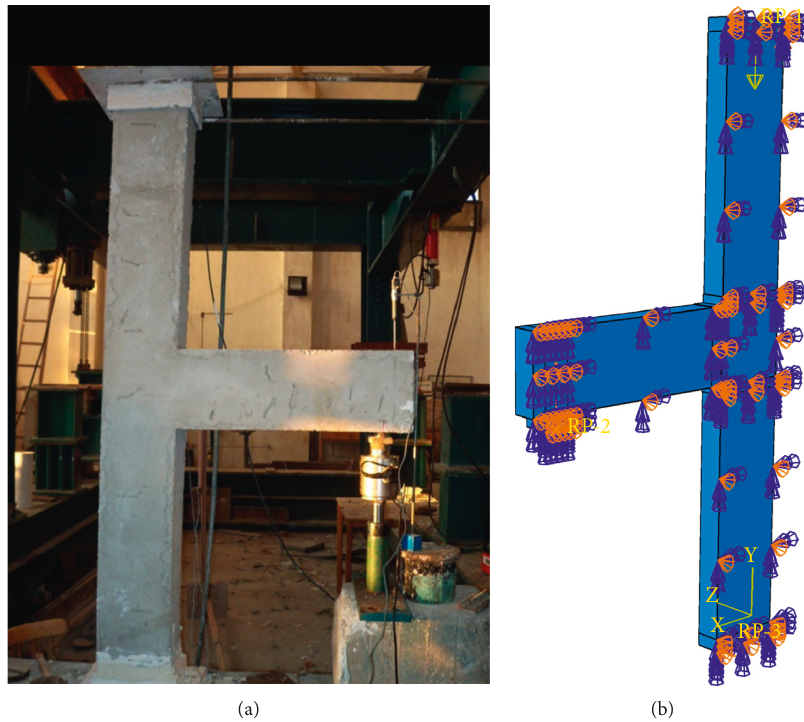
Figure 3: Boundary conditions and loading: (a) test setup [25] and (b) finite